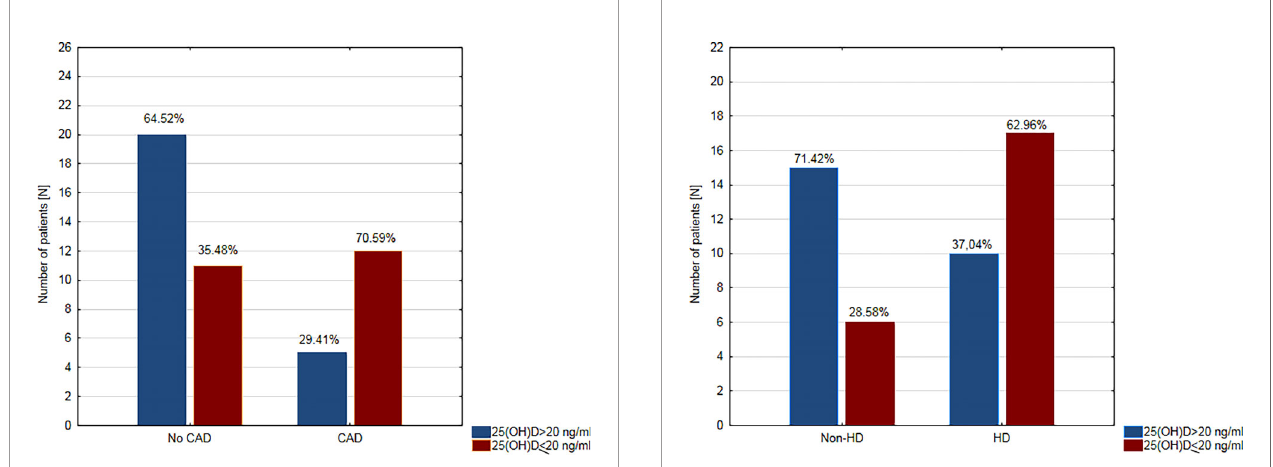
FIGURE 2 | Prevalence of vitamin D de fi ciency in hemodialysis (HD) and non- dialysis patients